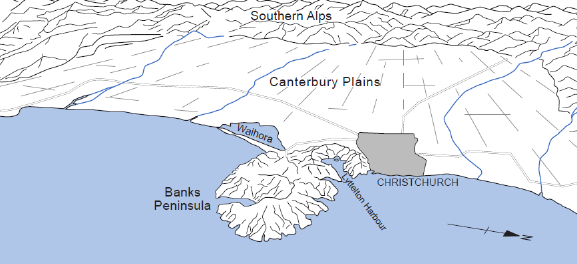
Figure 1 The view of the Christchurch (Sturman and Spronken- Smith,